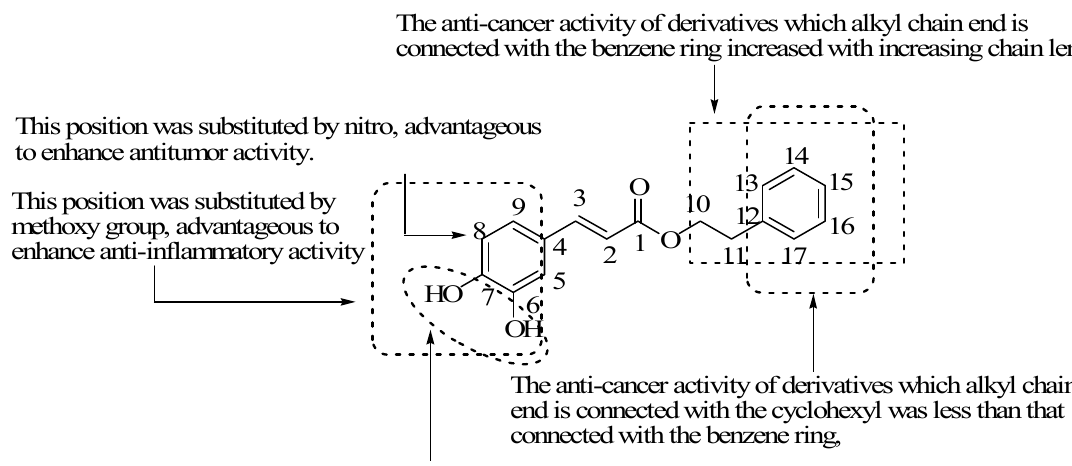
Figure 18. The structure-activity relationship of CAPE and its biological